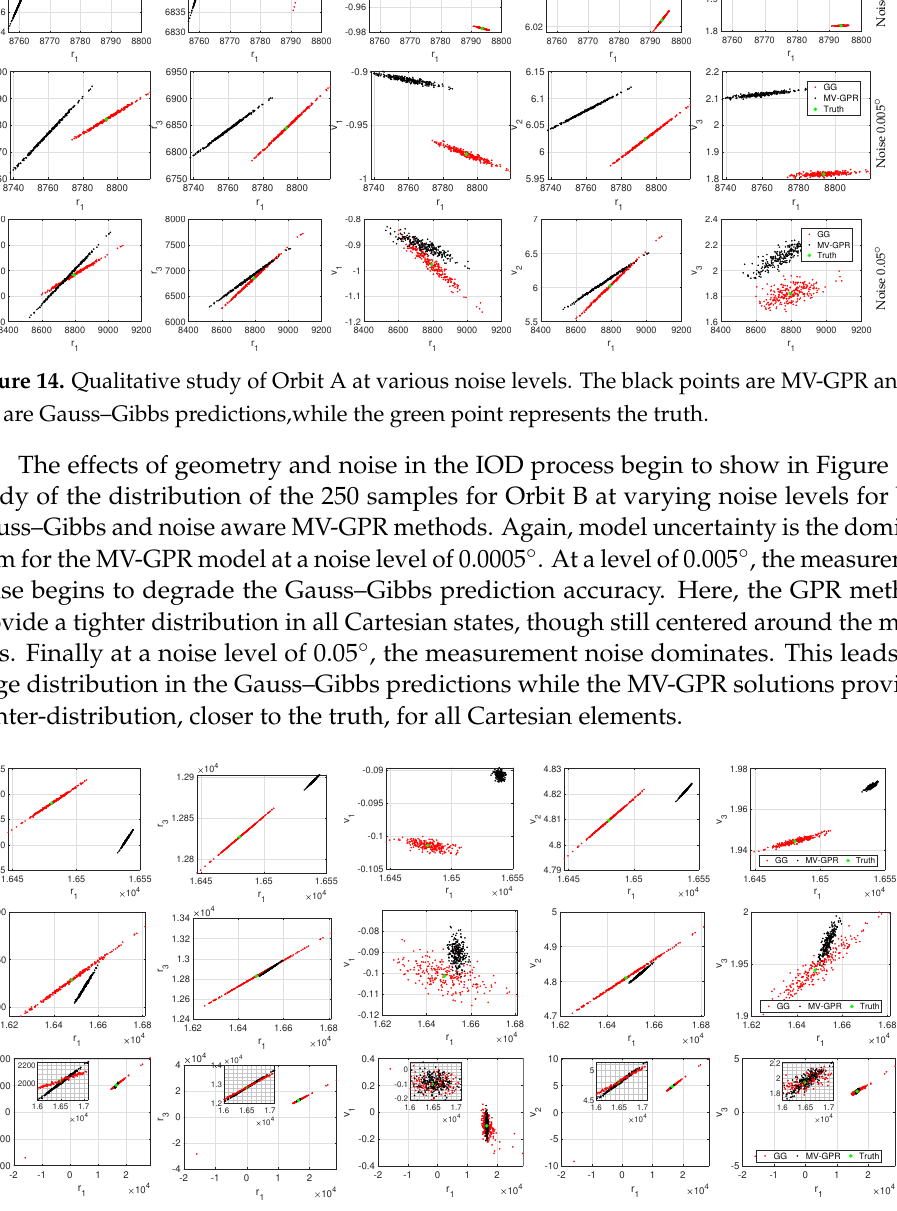
Figure 15. Qualitative study of Orbit B at various noise levels. The black points are MV-GPR and the red are Gauss–Gibbs predictions,while the green point represents the